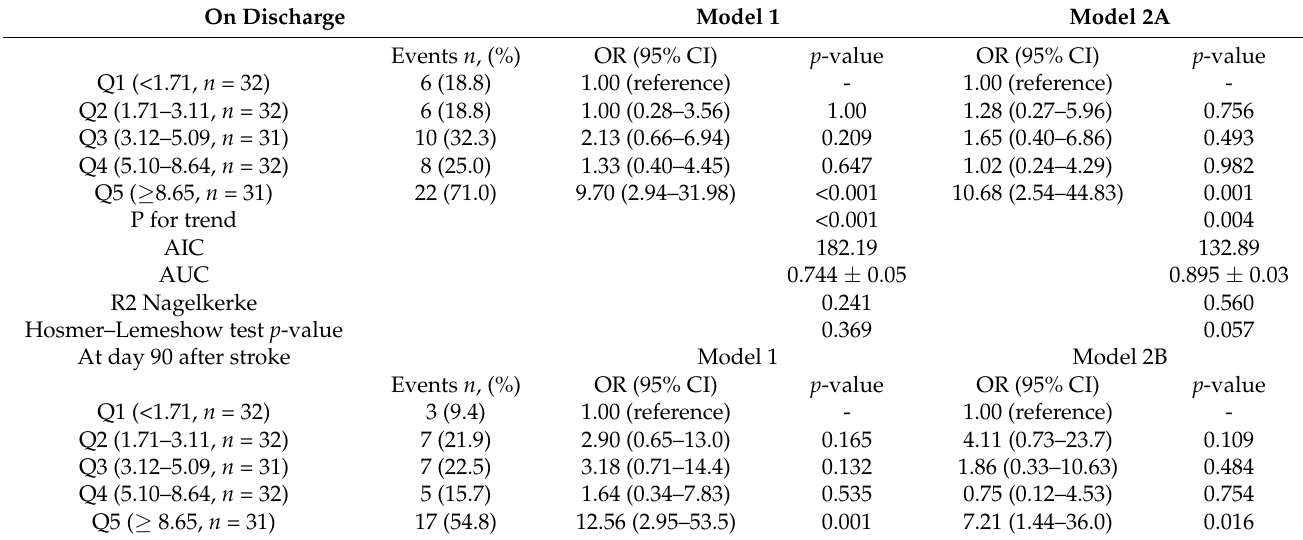
Figure 1. Panel ( A , B ). The proportion of patients with disability (modified Rankin Scale, mRS 3–6) or death (mRS = 6) on discharge and at day 90 after stroke onset, according to the quintile (quintile 1–quintile 5, Q1–Q5) of C-reactive protein (CRP) values. Panel ( C , D ). The proportion of patients with disability or death on discharge and at day 90 after stroke onset, according to the quartile (quartile 1–quartile 4, Q1–Q4) of white blood cell count (WBC). Table 2. C-reactive protein and poor functional outcome (mRS 3–6) on discharge and at day 90 after stroke.